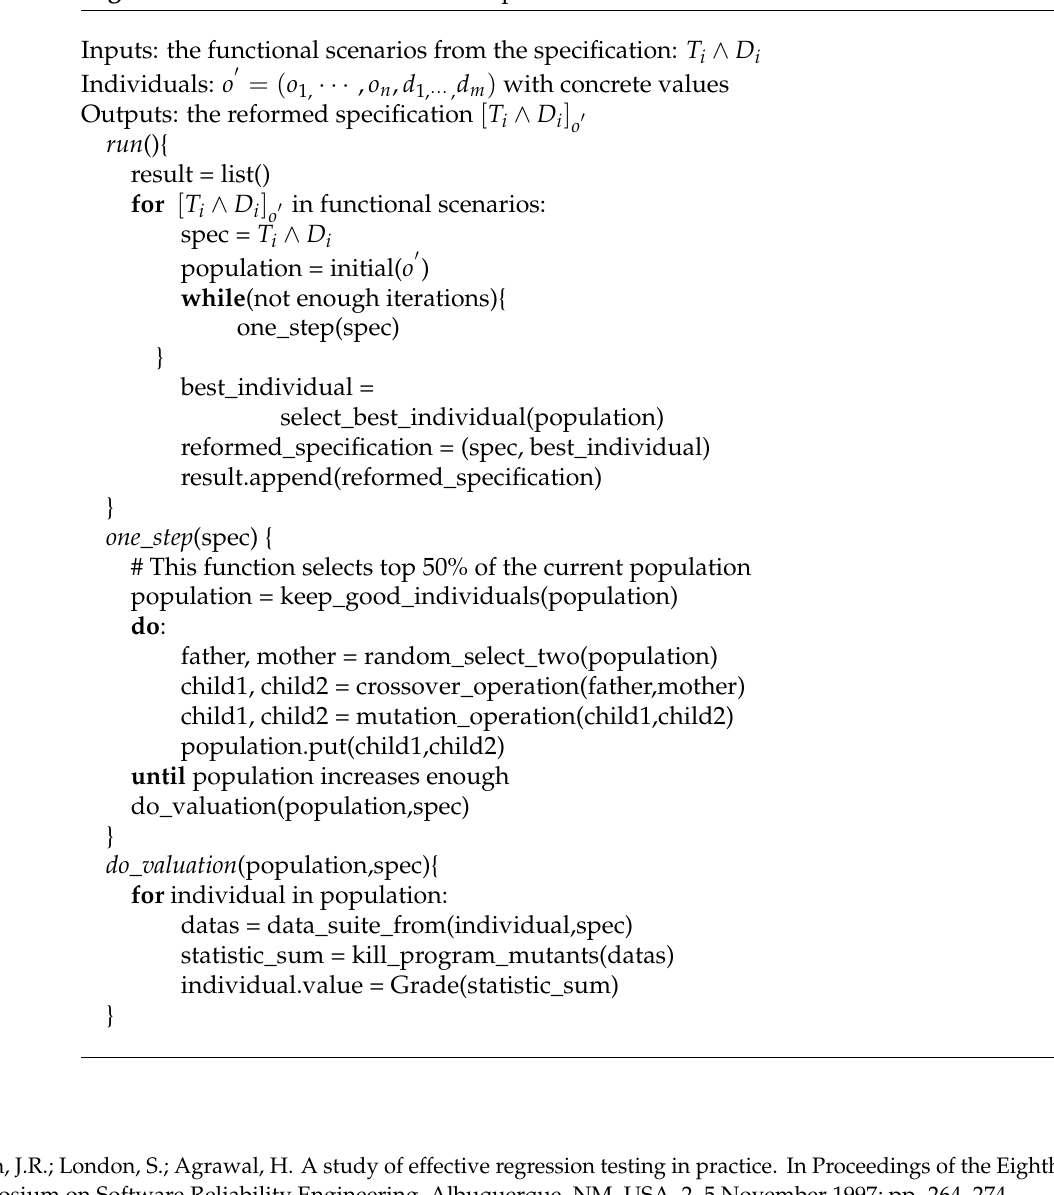
Algorithm A1 GA to obtain mutated